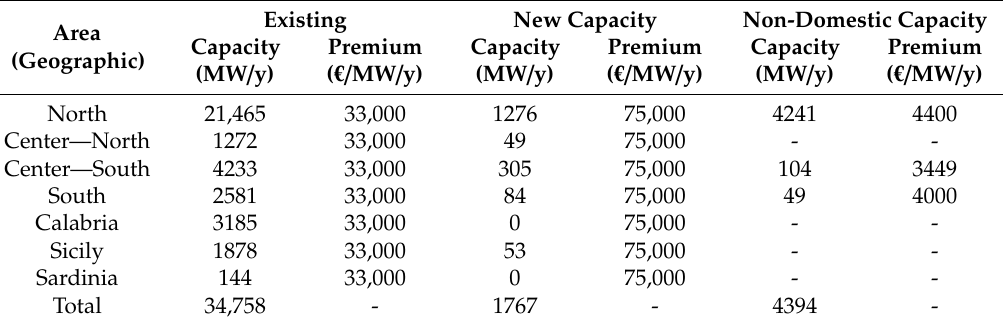
Table 5. Granted capacity under the 2022 capacity auction [22].